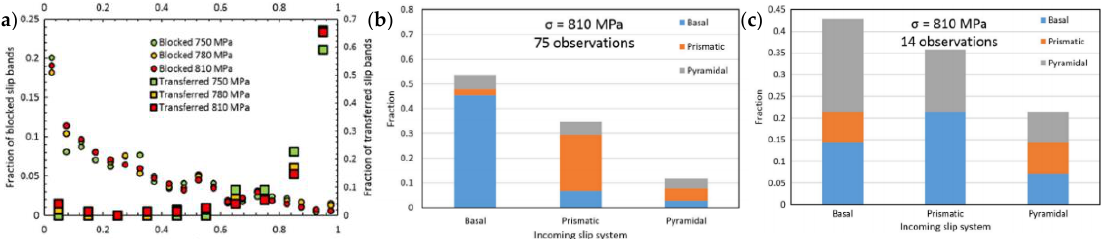
Figure 6. ( a ) The distribution of the frequency of slip transfer and blocking of different tensile stress relative to m′; ( b ) the distribution of outgoing slip systems with respect to incoming slip systems; ( c ) distribution of outgoing slip system excluding κ ϵ [0–15°] U ψ ϵ [0–15°] domain with respect to the incoming slip system [87].